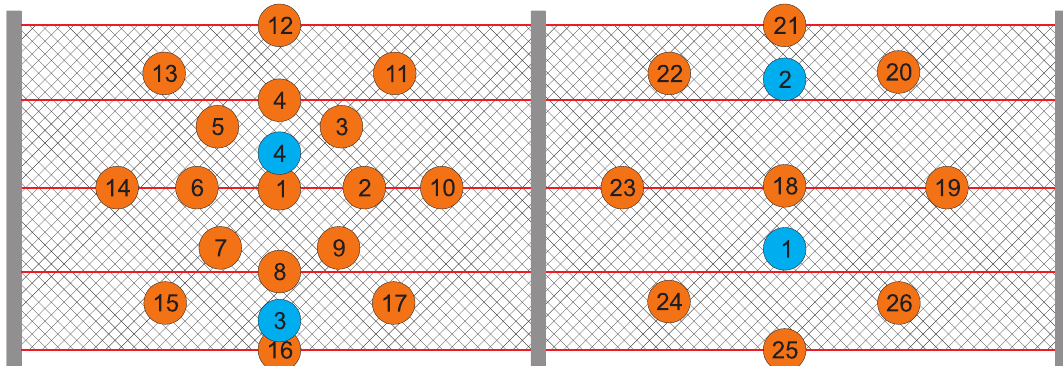
Figure 16. Installation positions on the protective fence of the first-generation accelerometer wireless sensor nodes (blue circles) and network powering locations at the given times (orange circles).